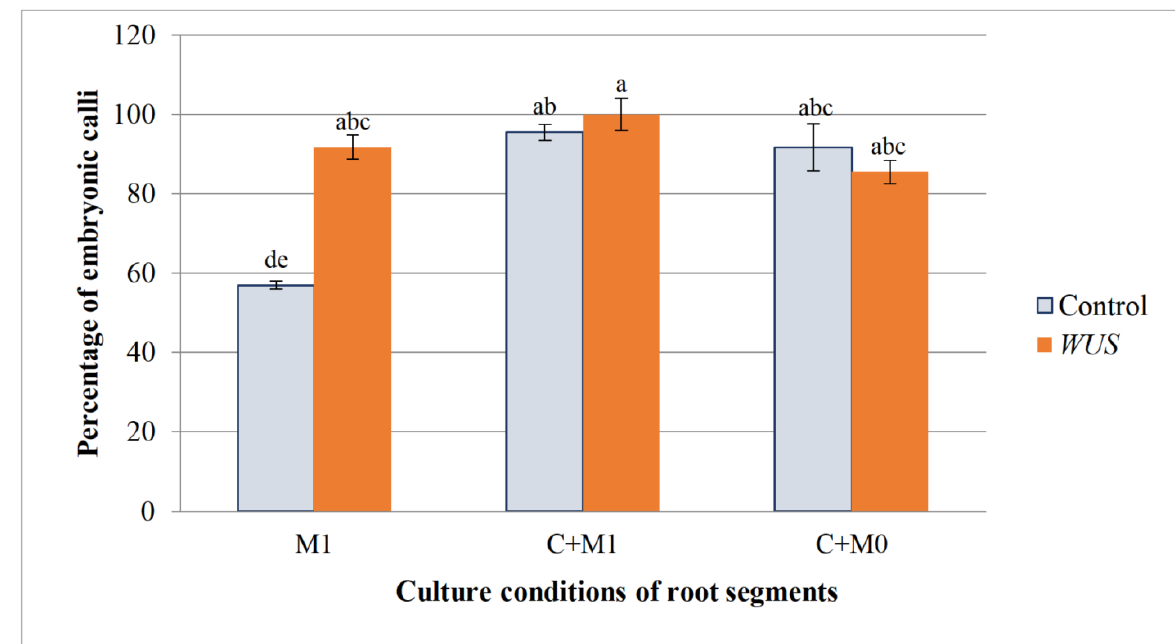
Figure 8. Embryogenic calli production from HR fragments of Medicago truncatula . Percentage of embryonic calli formed on hairy root segments of M. truncatula transformed by pCambia- BAR (Control) and pCambia1301- WUS - BAR l ( WUS ) cultured in 3 different conditions: directly on M1 medium containing 50 mg · L − 1 NAA and 1.5 mg · L − 1 BAP (M1); first, a callogenesis stage on C medium (5 mg · L − 1 2,4 -D and 0.5 mg · L − 1 BAP) and then transferred to M1 medium (C+M1); first a callogenesis stage on C medium and then transferred to M0 medium without growth regulator (C+M0). For each condition, 60 root explants were cultured per replicate. Three replicates were performed for each condition. Bars with different letters were significantly different at p <